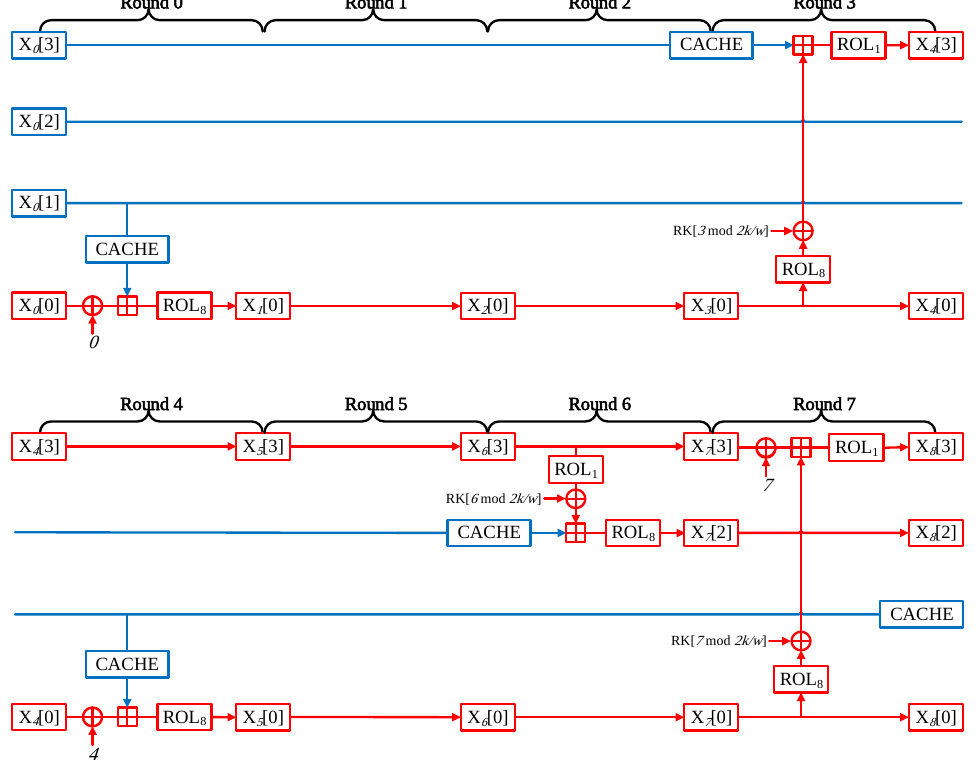
Figure 2. Optimized CHAM-Counter (CTR) mode encryption for round